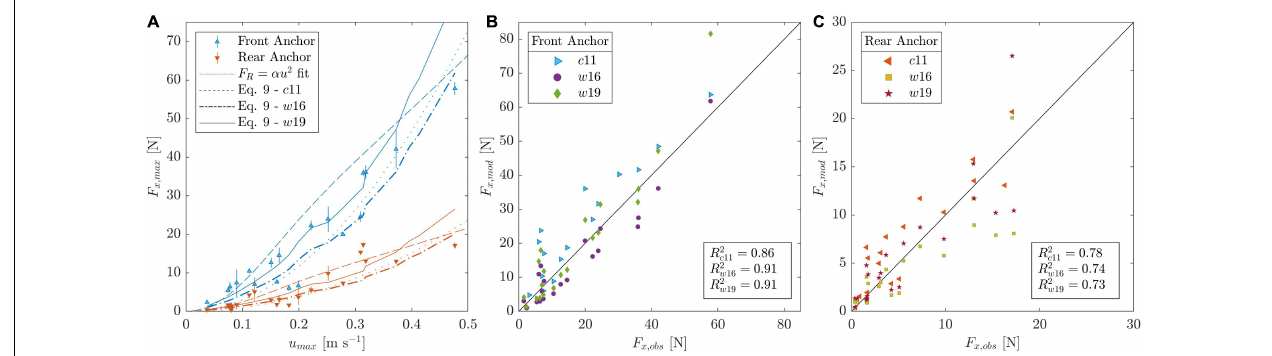
FIGURE 12 | Measured (obs; using both 1 and 2-mat measurements) and modeled (mod) horizontal forces utilizing Equation 9 for the unidirectional flow forces model ( c 11) and wave-induced forces models ( c 16 and c 19). (A) the maximum measured horizontal force and modeled forces as a function of the maximum horizontal orbital velocity u max . (B,C) show the plots of modeled versus observed forces depending on the anchor position. Note the different axis scales. Uncertainties of modeled forces and observations in panels (B,C) omitted for